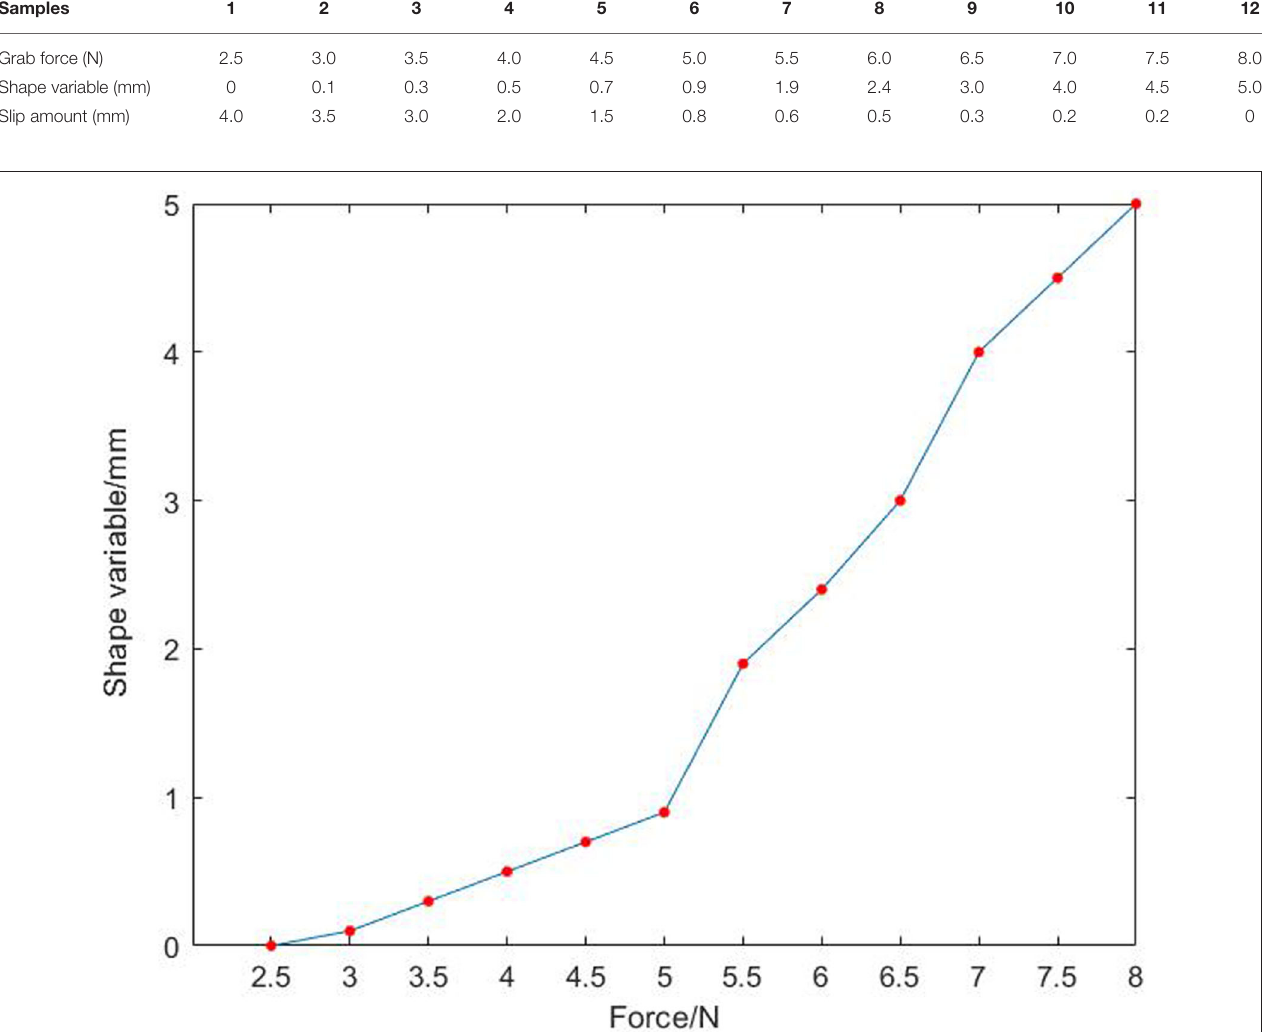
FIGURE 10 | Diagram of the relationship between force and gasket deformation after the installation of sensor.